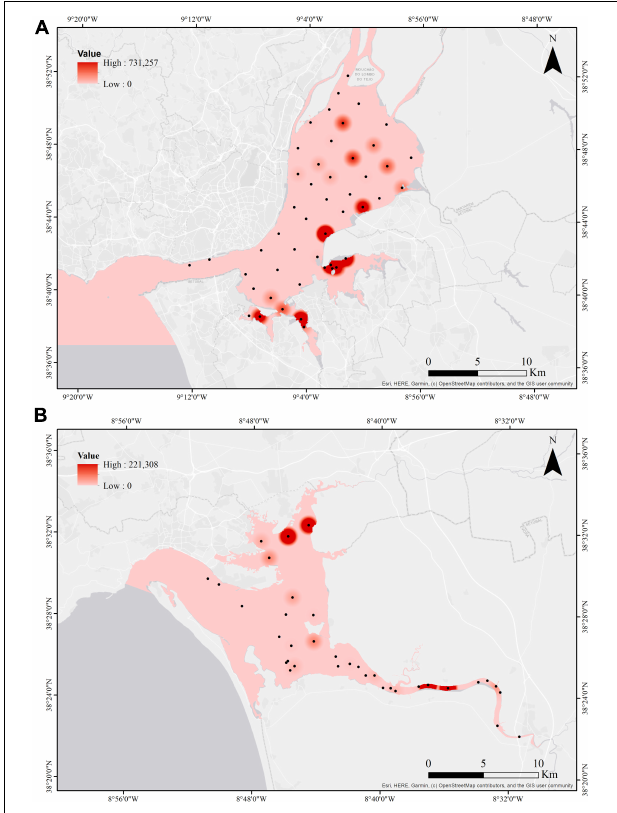
FIGURE 3 | Illustrative map of cockle distribution and mean cockle abundance over the three years (2015, 2018, and 2019) at each sampling station in the Tagus (A) and Sado estuaries (B) .